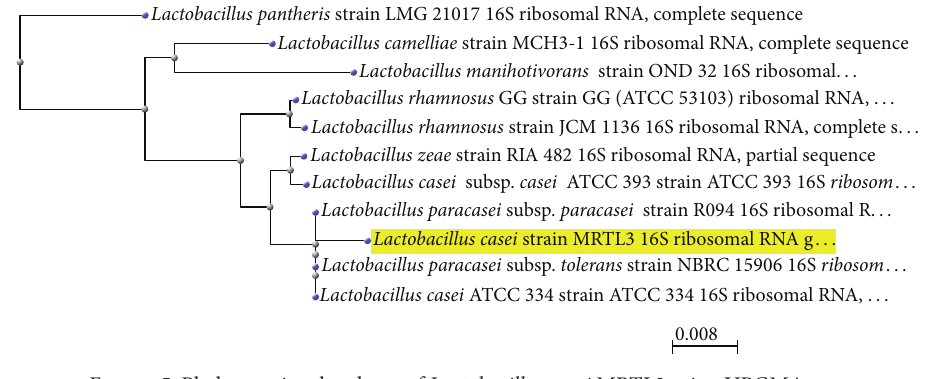
Figure 5: Phylogenetic relatedness of Lactobacillus casei MRTL3 using UPGMA